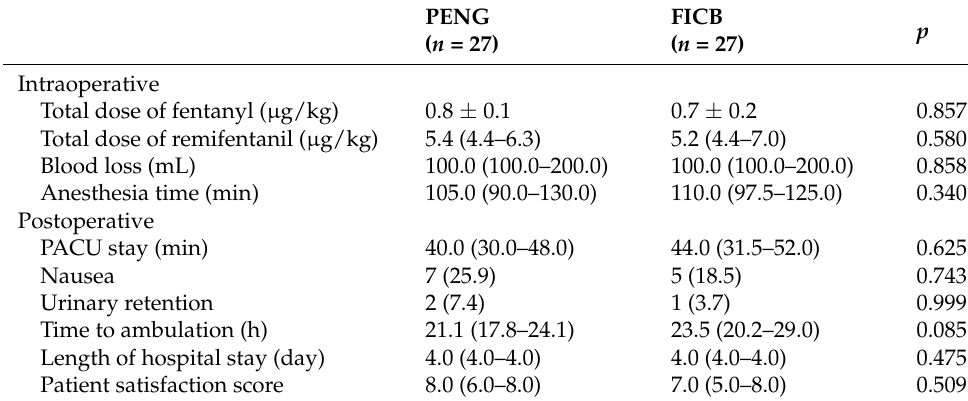
Table 4. Intraoperative and postoperative